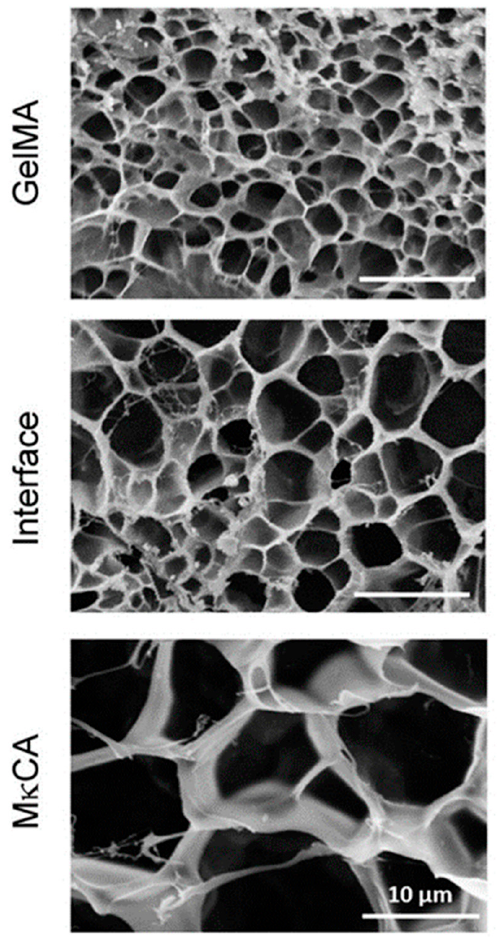
Figure 5. Scanning electron micrographs of gradient hydrogels (GelMA-M κ CA). A significant change in pore size distribution was observed [12].